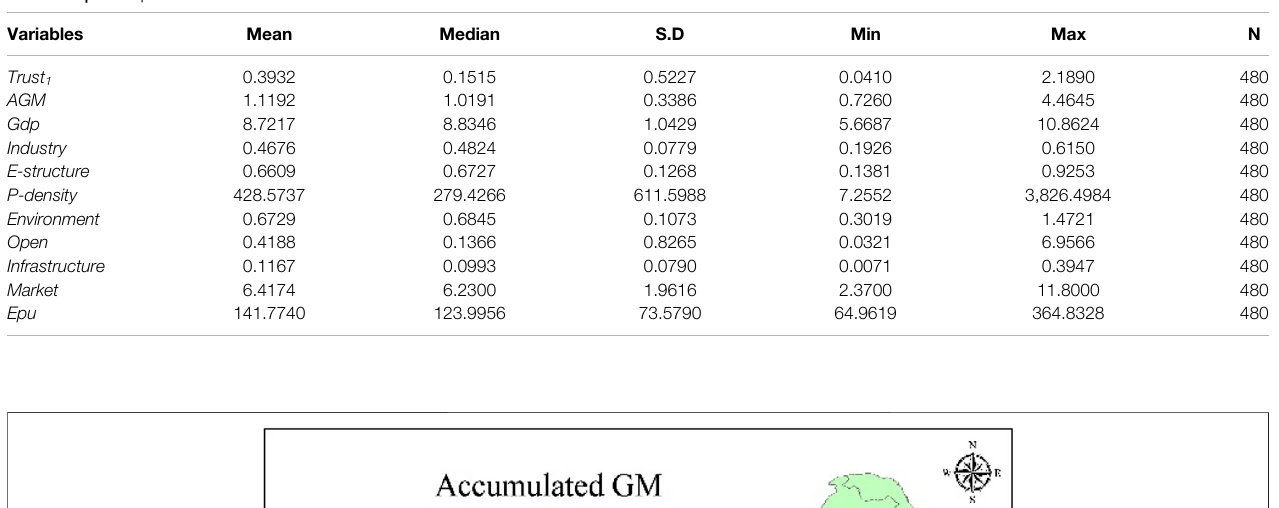
TABLE 2 | Descriptive statistics.